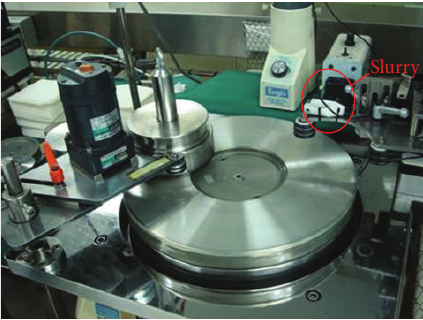
Figure 6: Lapping machine.